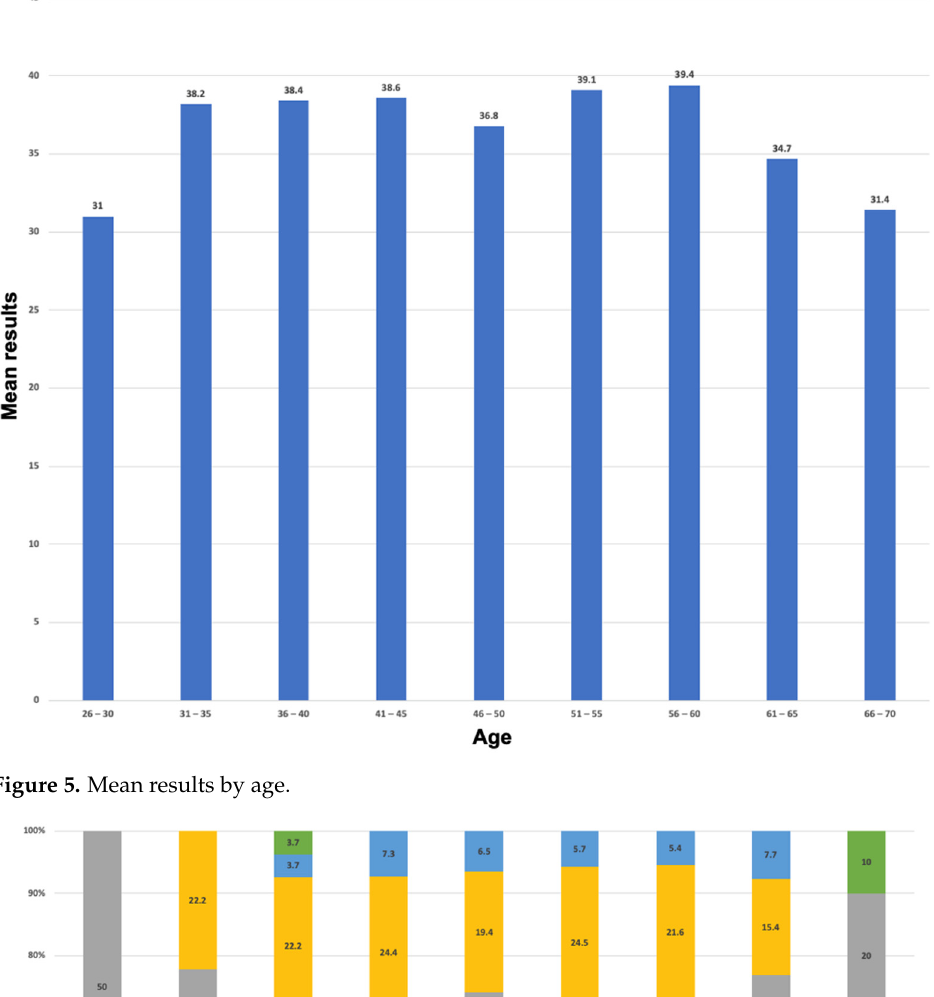
Figure 5. Mean results by age.